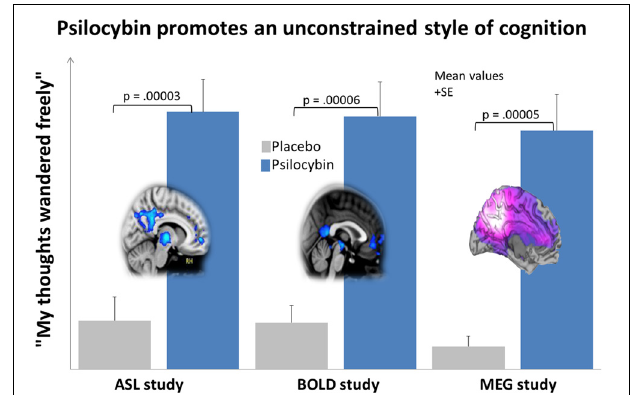
FIGURE 5 | Psilocybin promotes unconstrained thinking and decreases blood flow, venous oxygenation and oscillatory power in the DMN. This chart shows the average ( + SE ) ratings for the item “my thoughts wandered freely” in 3 neuroimaging studies, each involving the administration of psilocybin and placebo to 15 healthy volunteers. Ratings were given within 30min of the end of the relevant resting state scans. This particular item was one of the highest rated items in all 3 studies and nicely communicates the quality of cognition that predominates in the psychedelic state. The brain image on the left displays the mean regional decreases in CBF post-psilocybin in the ASL study; the central image displays the mean regional decreases in BOLD signal post-psilocybin in the BOLD study; and the image on the right displays the mean regional decreases in alpha power post-psilocybin in the MEG study. All images were derived using a whole brain corrected threshold of p < 0 .